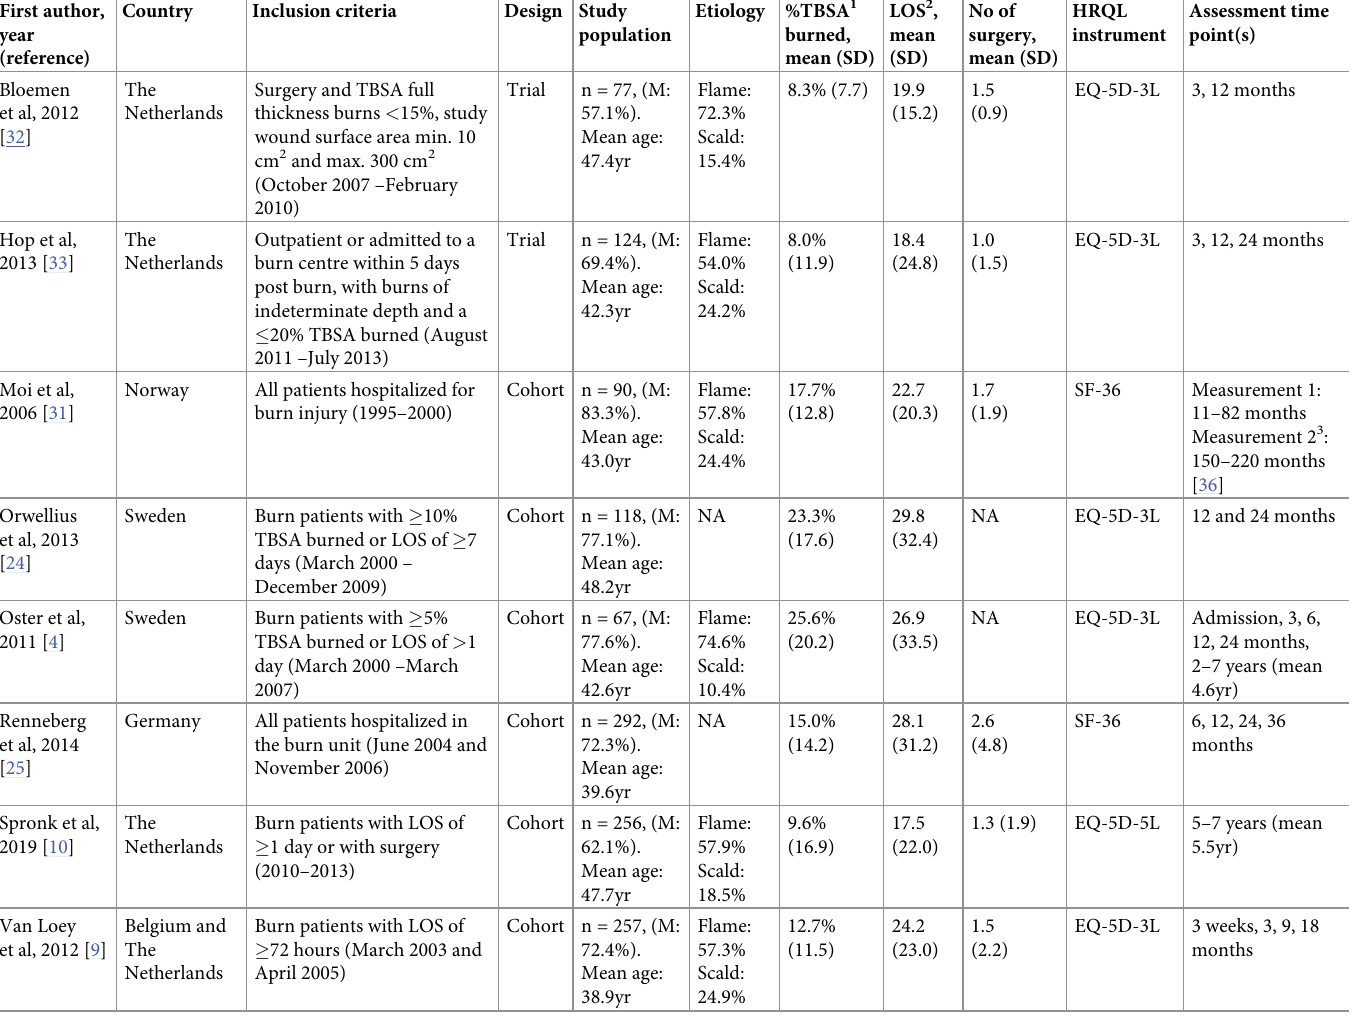
Table 1. Characteristics of included patients from the different